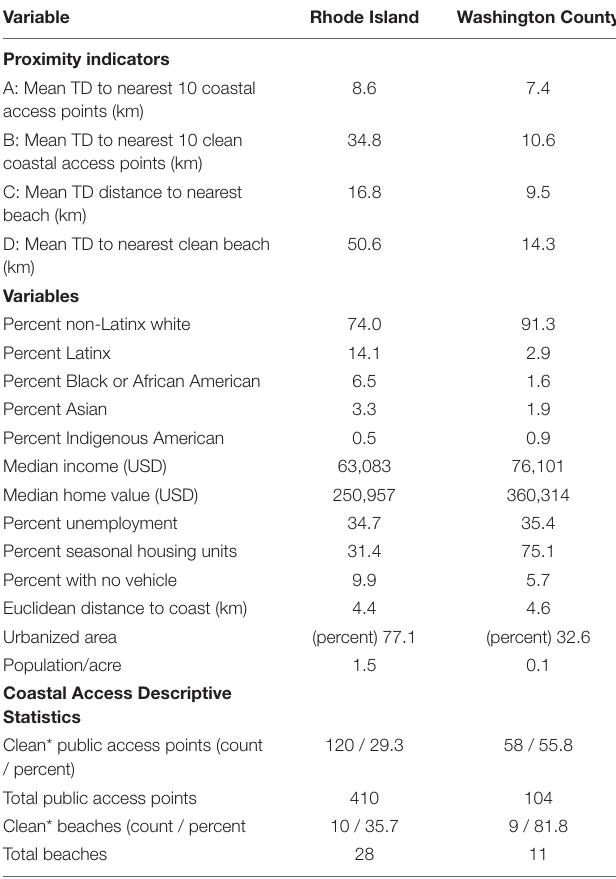
TABLE 2 | Summary statistics (2016) for all variables in Rhode Island and Washington County,